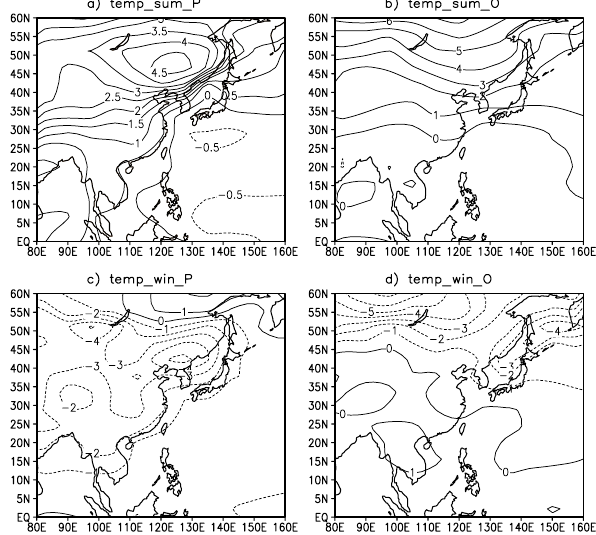
Fig. 4. Composite differences for surface air temperature ( ◦ C) over East Asia on the precession (left, PL-PH) and obliquity (right, TH- TL) bands: (a, b) summer (JJA); (c, d) winter (DJF). See more in the text.